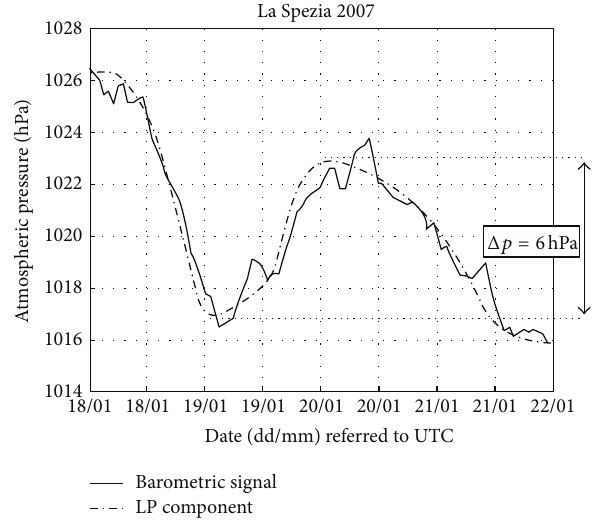
Figure 3: The barometric signal recorded by La Spezia Newtonian Meteo-tide Station between 18.01.2007 and 22.01.2007 and its low pass component, 𝐹 𝑐 = 10 −5 Hz (image from